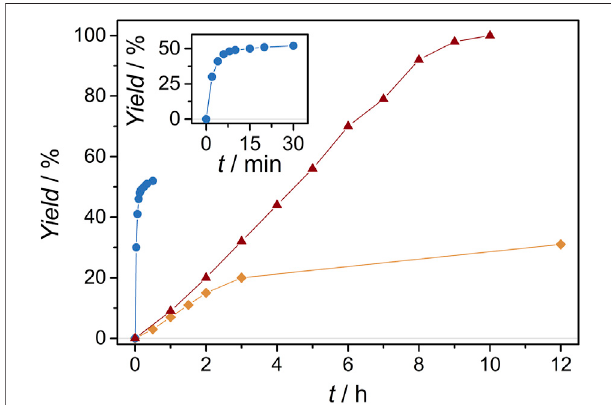
FIGURE 4 | Conversion vs. time plots of the photoredox catalyzed radical cation Diels-Alder cycloaddition of t An and DMB using [Cr(tpe) 2 ] 3+ (red triangles), [Cr(dmcbpy) 3 ] 3+ (orange diamonds) and [Ru(bpz) 3 ] 2+ (blue circles) photocatalysts (0.2 mM) in CH 3 CN with 460 nm light excitation. The inset shows a zoom of the conversion vs. time plot of the rapid but incomplete reaction with [Ru(bpz) 3 ] 2+ as